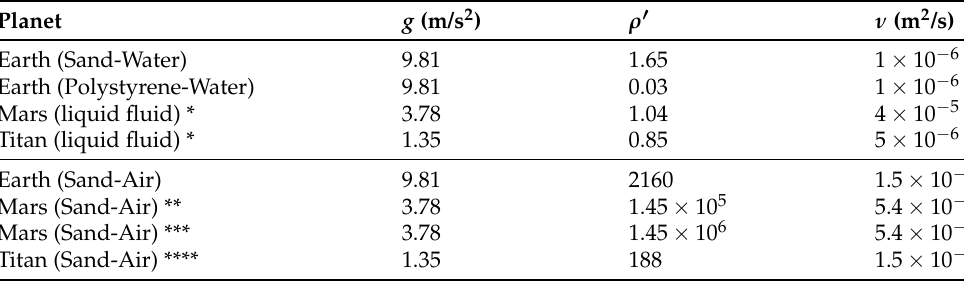
Table 1. Some characteristic data of planets with respect to ripples.